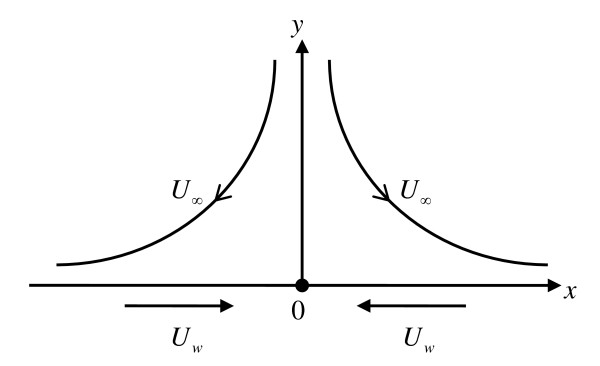
Physical model and coordinate system.